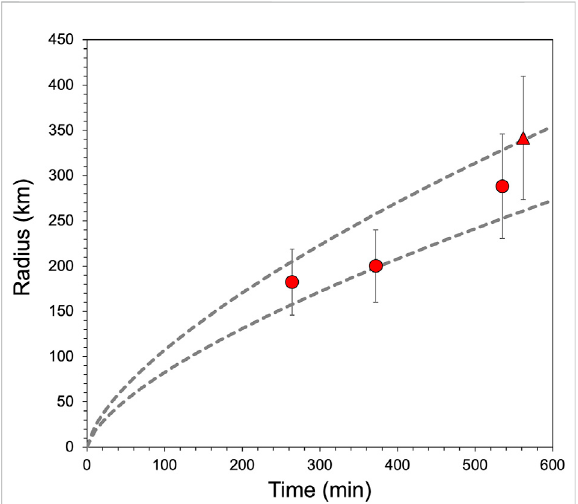
FIGURE 4 Equivalent radius of the January 13 – 14, 2022 HTHH umbrella cloud as observed in DSCOVR/EPIC ( circles ) and S5P/TROPOMI ( triangle ) SO 2 data between 19:56 UT on January 13 and 00:54 UT on January 14. Error bars denote 20% uncertainty on the cloud radii. Gray lines show the evolution of umbrella cloud radius predicted by the Woods and Kienle [1994] model for two volumetric fl ow rates (VFR) that bracket the satellite observations, assuming an eruption onset at 15:32 UT on January 13. The lower and upper bounds correspond to VFRs of 6.3 and 13.8 km 3 s − 1 ,